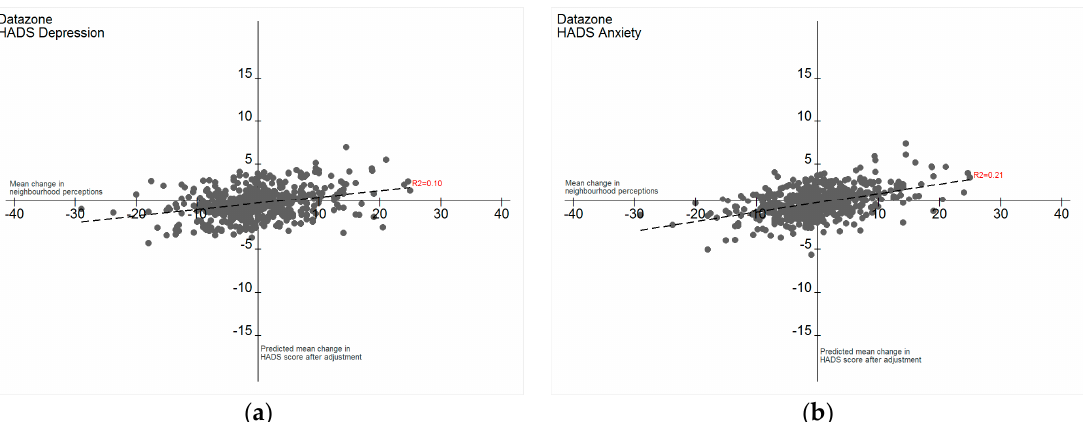
Figure 1. ( a ) Change in overall neighbourhood perceptions and predicted change in HADS depression, over time; ( b ) change in overall neighbourhood perceptions and predicted change in HADS anxiety, over time. Table 4. Correlation coefficients (r 2 ) of association between mean change in neighbourhood perceptions and predicted mean change in HADS scores after adjustment by socio-economic status 1 .